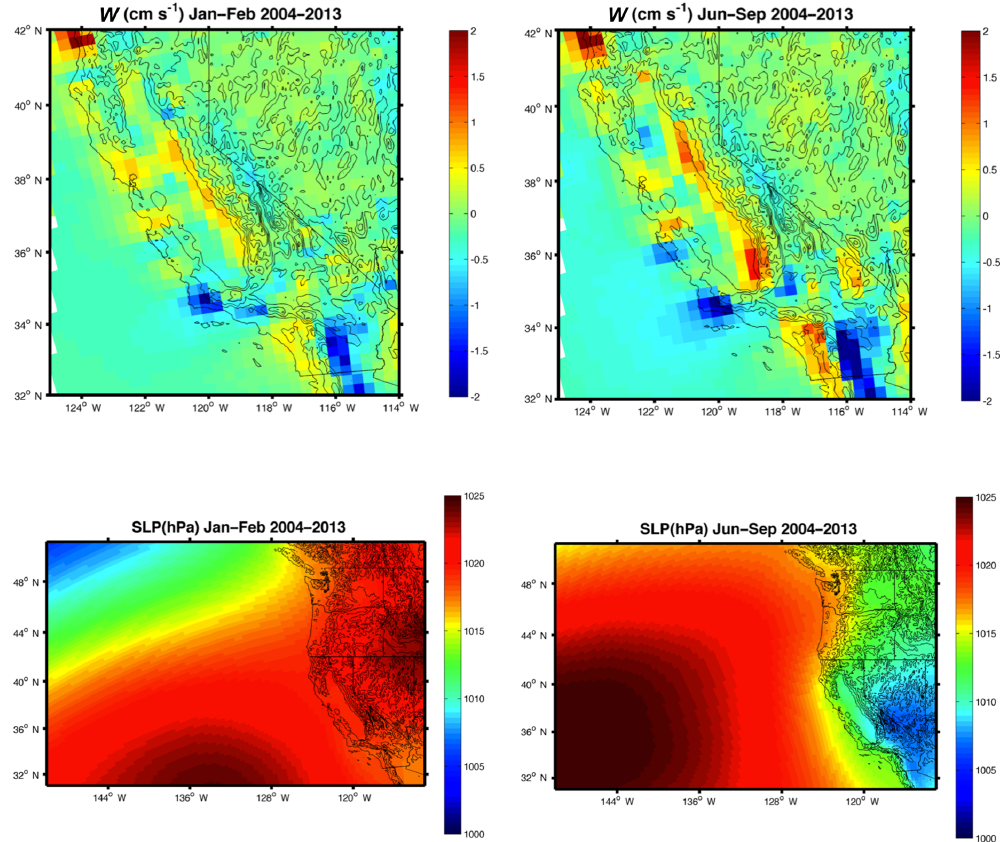
Figure 1. W (vertical velocity), converted from omega (pressure velocity), at the 900hPa level and mean sea-level surface pressure. Plotted for two intervals, January–February and June–September, for 10 years from 2004 to 2013. The months chosen for the two separate plots represent the time frame of the flights. SLP: sea-level